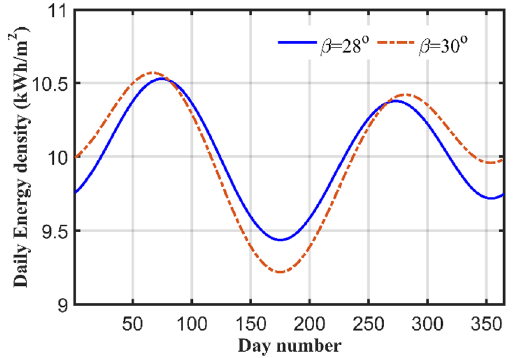
Figure 8. Comparisons between the radiation at OTA and the latitude angle.